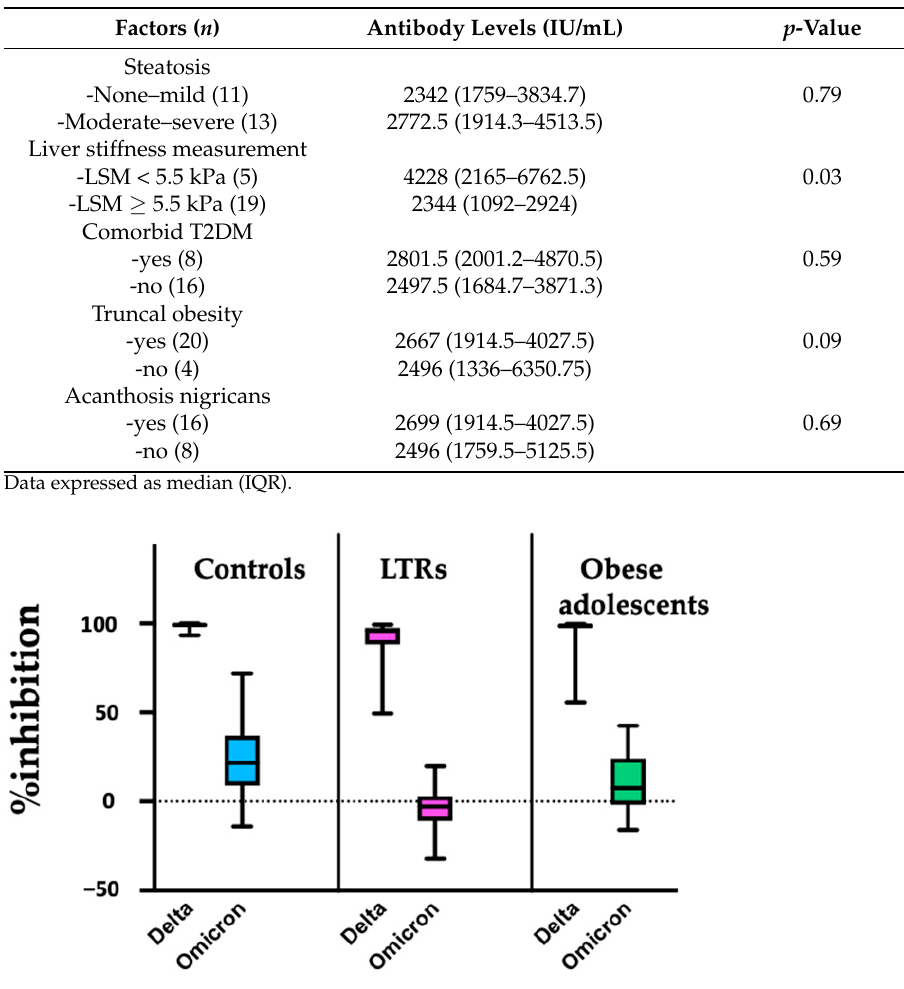
Figure 2. Comparison of sVNT (%inhibition) between Delta and Omicron (BA.1) variants after administering the second dose of BNT162b2 in healthy controls, LTRs, and obese adolescents.